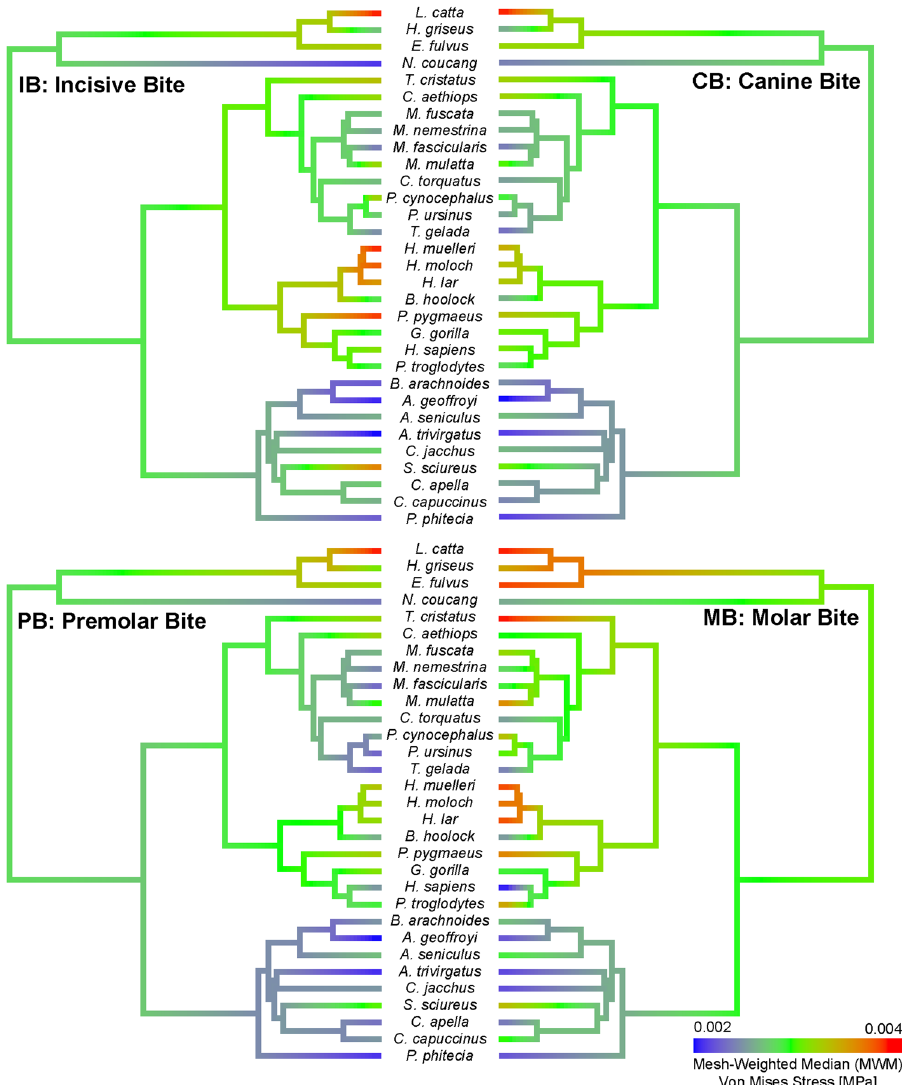
Figure 5. MWM values for each species mapped on the phylogeny for the four biting scenarios. The values at nodes and branches were reconstructed using a maximum-likelihood ancestral character estimation method based on a Brownian motion model of evolution. The colour ranges from red representing higher average stress values, to blue, representing lower stress